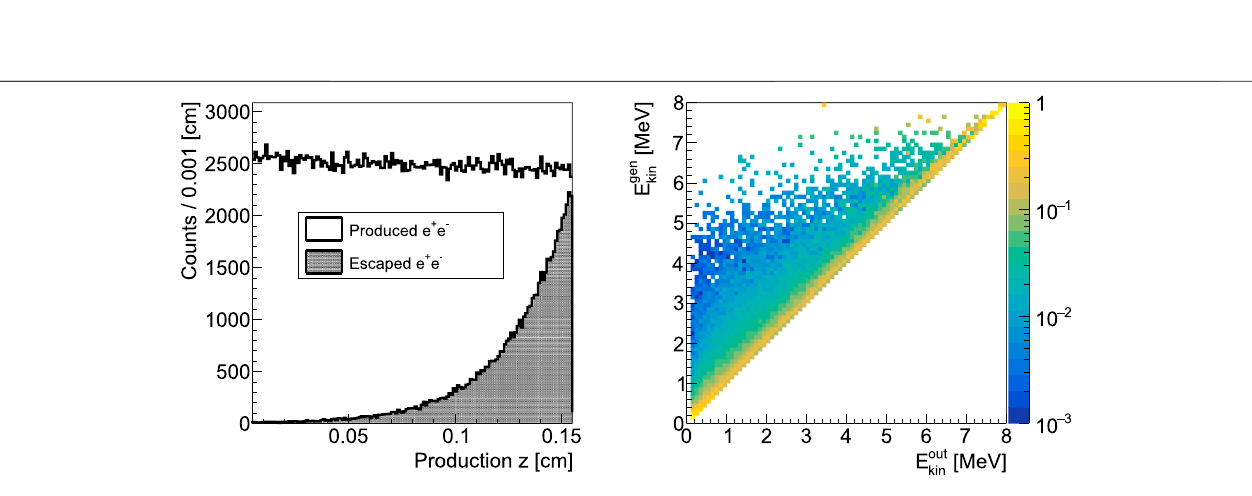
Frontiers in Physics |